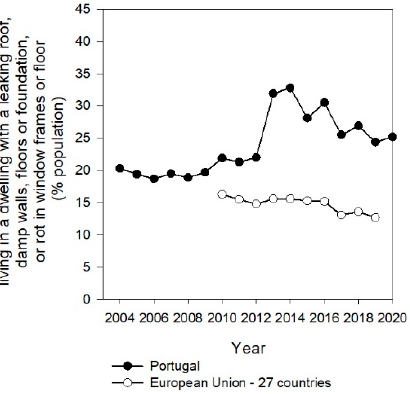
Figure 6. Proportion of inhabitants living in a dwelling with a leaking roof, damp walls, floors or foundation, or rot in window frames or floor (data source [68]).